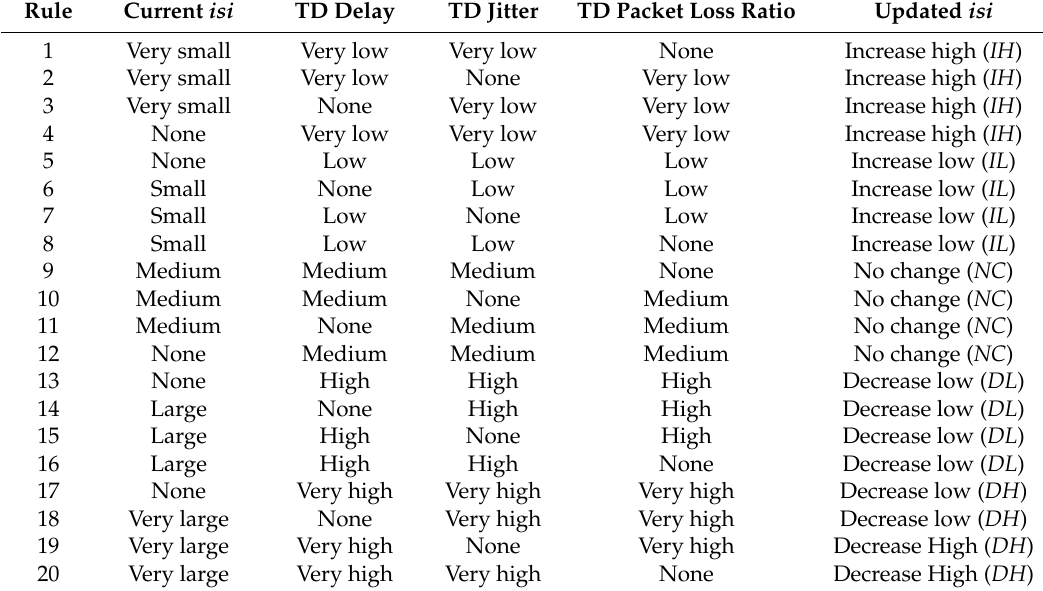
Table 3. Rules included in the FIS knowledge base (TD is time